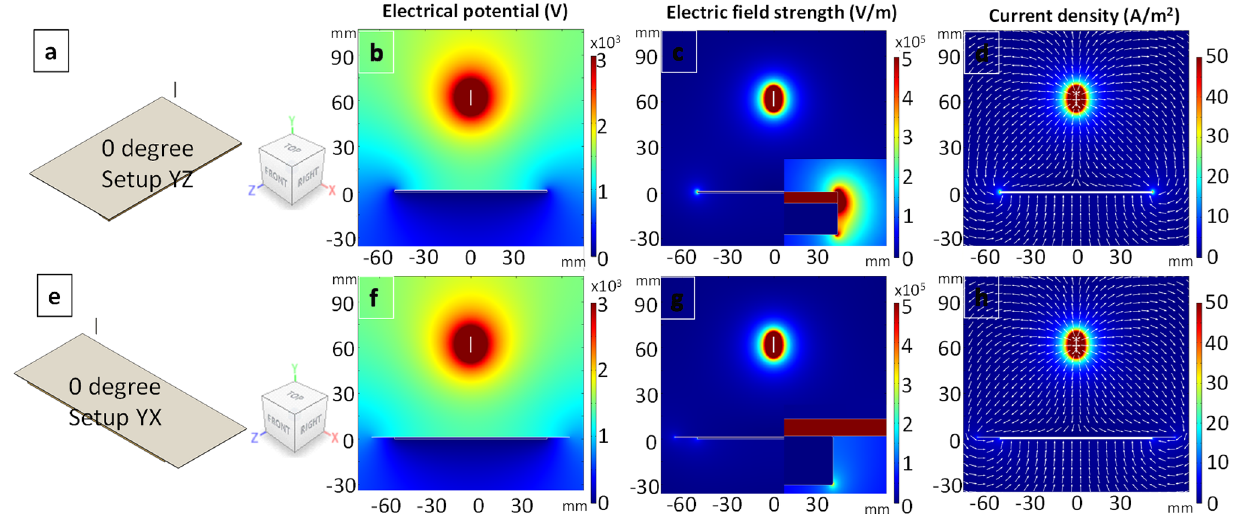
Figure 6. ( a – h ) Simulations showing the effect of changing the angle of the Vee-shield to 0°. The cross-sectional view planes are shown in ( a and e ). The simulations for the electrical potential, electric field strengths and current density in the YZ and YX planes are shown in ( b – d ) and ( f – h )